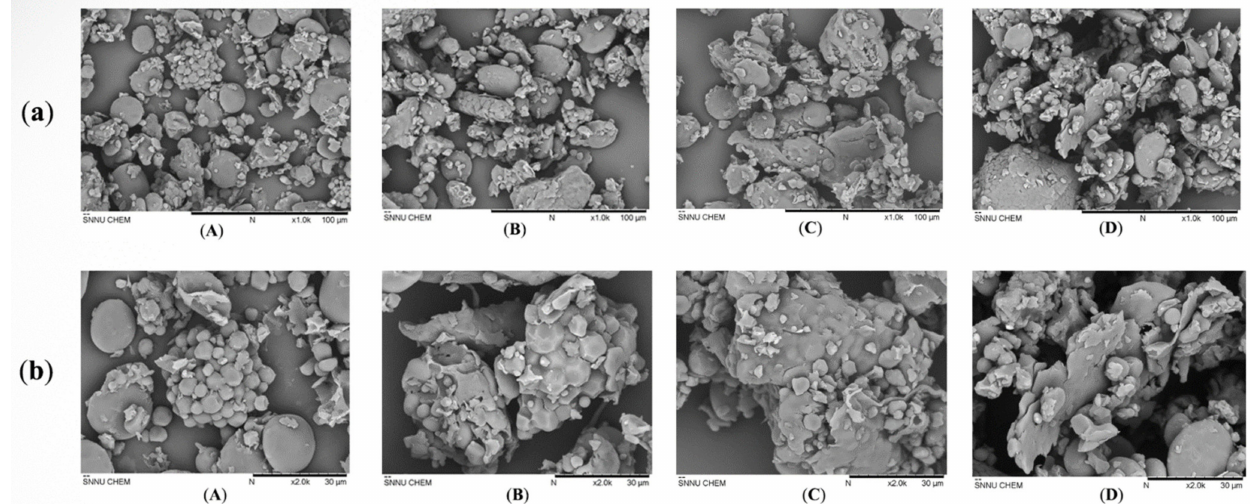
Figure 2. Microstructure (( a ) 1000 × magnification; ( b ) 2000 × magnification) of buckwheat-based composite flour treated with chlorine dioxide at different treatment concentration: ( A ) 0 ppm; ( B ) 76 ppm; ( C ) 152 ppm; ( D ) 232